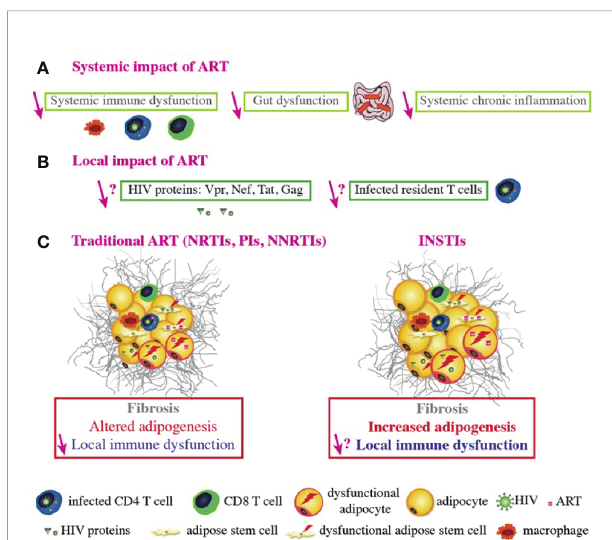
FIGURE 3 | ART-related fat alterations. ART controls HIV replication, improves systemic immune function, decreases chronic in fl ammation, promotes immune reconstitution and function, improves gut function and integrity, and decreases the viral load and viral protein concentration in the blood (A) . However, it is not known whether ART decreases the number of infected T cells or the viral protein concentration within AT (B) . Regarding conventional ART, the NRTIs stavudine and zidovudine, some PIs boosted by ritonavir, and the NNRTI efavirenz (EFV) induce alterations in AT such as fi brosis, altered adipogenesis, and local immune dysfunction. ART does improve immune function and expression levels of some adipogenic markers (e.g. PPAR g ) in the AT, relative to treatment-naive HIV-infected patients. However, adipogenic marker expression is still lower than in non-infected people. ART induces mitochondria dysfunction and alters adipogenesis in both ASCs and adipocytes. ART-treated adipocytes present with oxidative stress and insulin resistance. Furthermore, some ARVs induce pro- in fl ammatory adipokine/cytokine secretion by adipocytes, ASCs and macrophages and CD8 T cells accumulation; this contributes to AT immune dysfunction and in fl ammation. It was recently reported that some INSTIs can be associated with fat and weight gain, adipogenesis, fi brosis, and adipocyte hypertrophy/dysfunction, with increased insulin resistance in vitro . INSTIs also induce collagen production, mitochondrial dysfunction, and oxidative stress in both ASCs and adipocytes, which might promote fi brosis. Nonetheless, the local impact of INSTIs on immune cells within the AT remains to be determined (C)